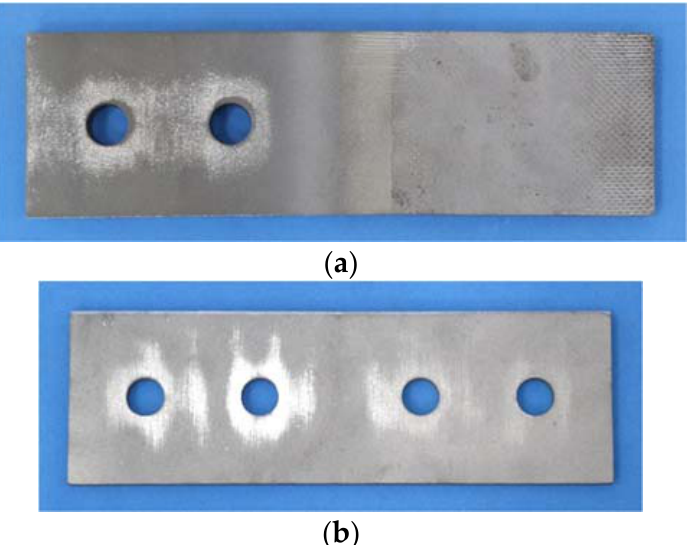
Figure 7. Abrasion around the bolt hole after the tests. ( a ) Inner plate (HVOF-coated). ( b ) Cover plate (grit-blasted).